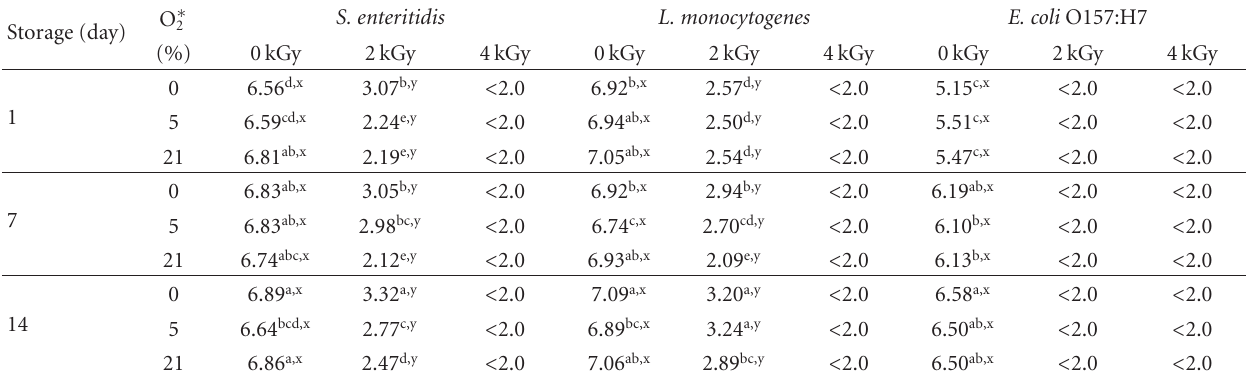
Table 2: Changes in S. enteritidis , L. monocytogenes , and E. coli O157:H7 counts (LogCFUg − 1 ) in ready-to-cook meatballs during storage at